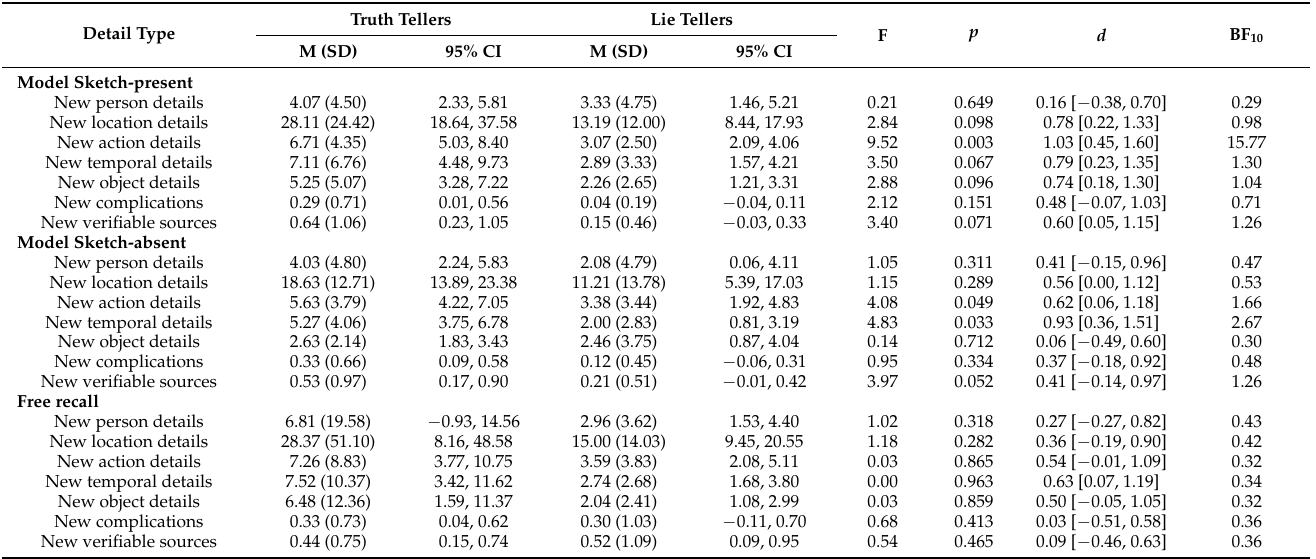
Table 5. Descriptive and Inferential Statistics for the Dependent Variables as a Function of Veracity and Modality in Phase